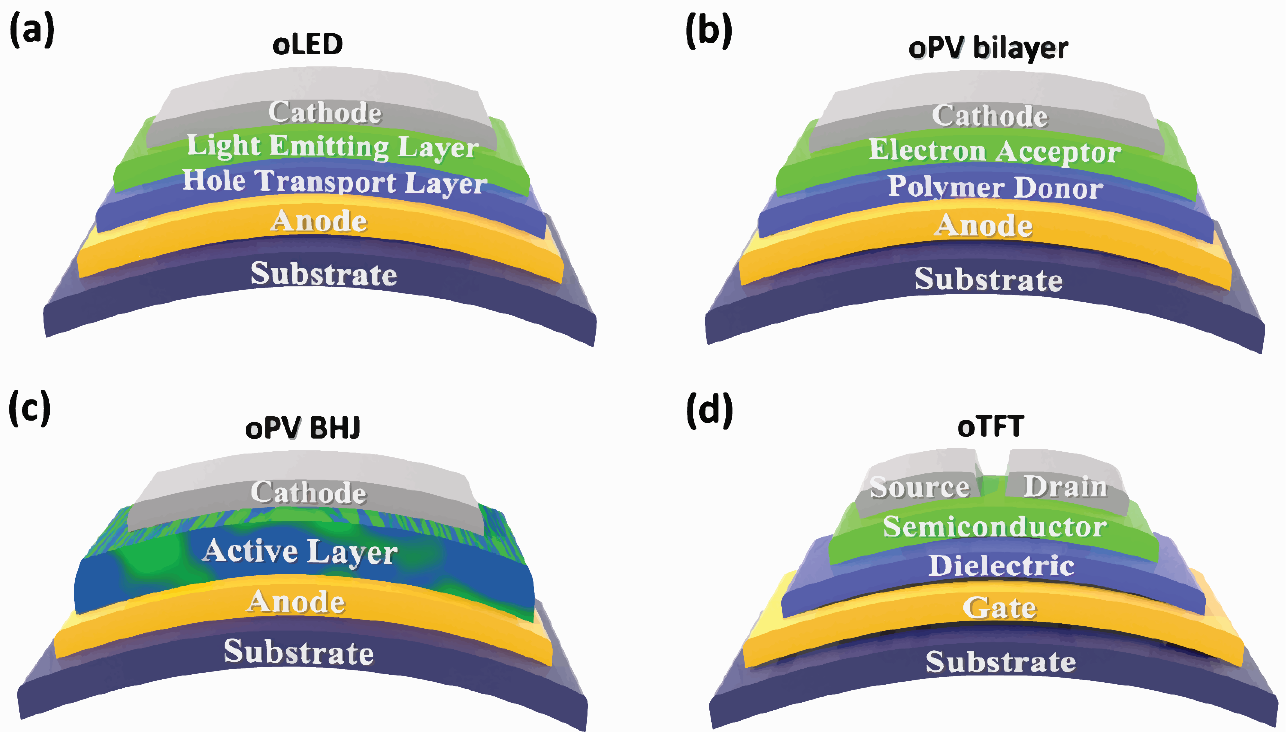
Figure 20. Schematic illustration of flexible organic device architectures based on semiconducting and conducting polymers, where they can be exploited in one or more layers in ( a ) an organic light ‐ emitting diode (oLED), ( b ) an organic photovoltaic (oPV) where the photoactive region has a bilayer structure, ( c ) an oPV with a bulk heterojunction (BHJ) photoactive region, and ( d ) an organic thin ‐ film transistor (oTFT) [11]. ( a – d ) Reproduced with permission [11]. Copyright 2021, De Gruyter.